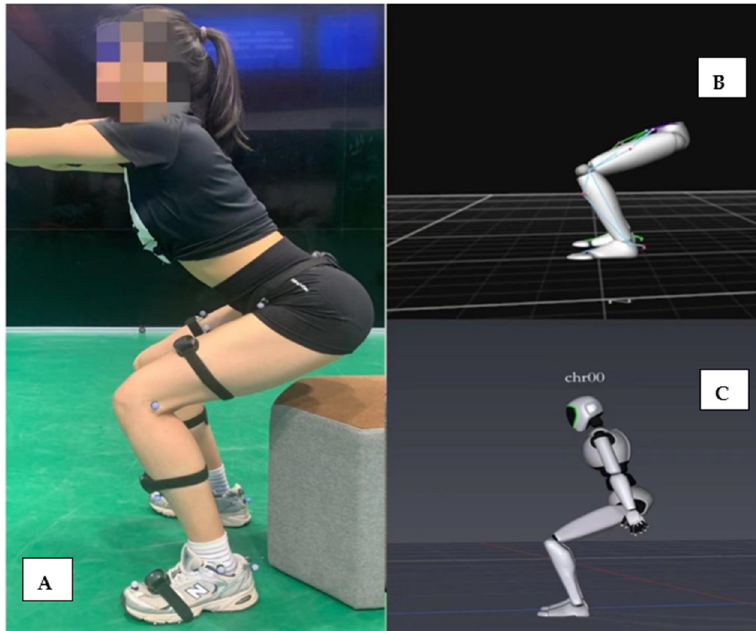
Figure 1. ( A ) Photograph of a participant wearing reflective markers and the Perception Neuron ® device during a squat trial. ( B ) A screenshot of the software program that was used to obtain motion data information from the OptiTrack device. ( C ) A screenshot of the software program that was used to obtain motion data information from the Perception Neuron ® device.